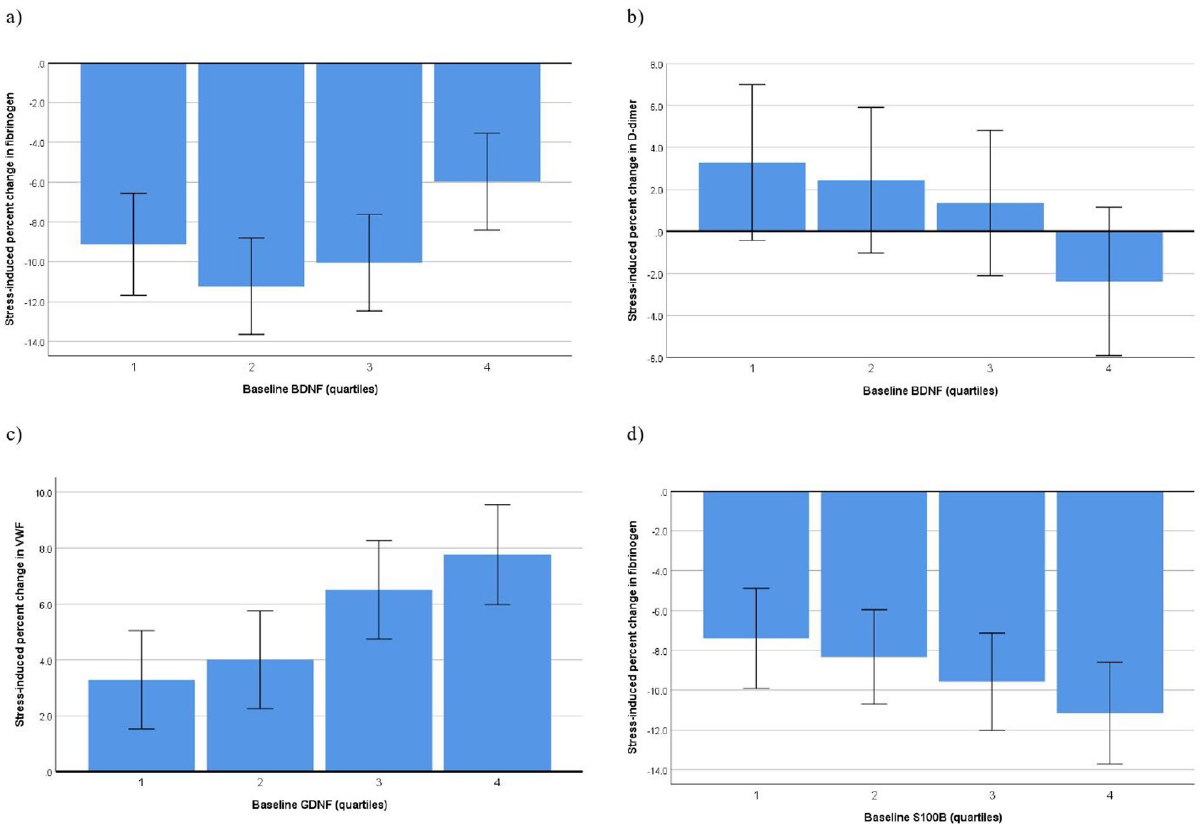
Figure 2. Fully adjusted significant associations between baseline values of neurotrophins across quartiles (1 = lowest quartile, 4 = uppermost quartile) and stress-induced percent changes in hemostatic factors. BDNF, brain-derived neurotrophic factor; GDNF, glial cell-derived neurotrophic factor; S100B, S100 calcium-binding protein; VWF, von Willebrand factor.